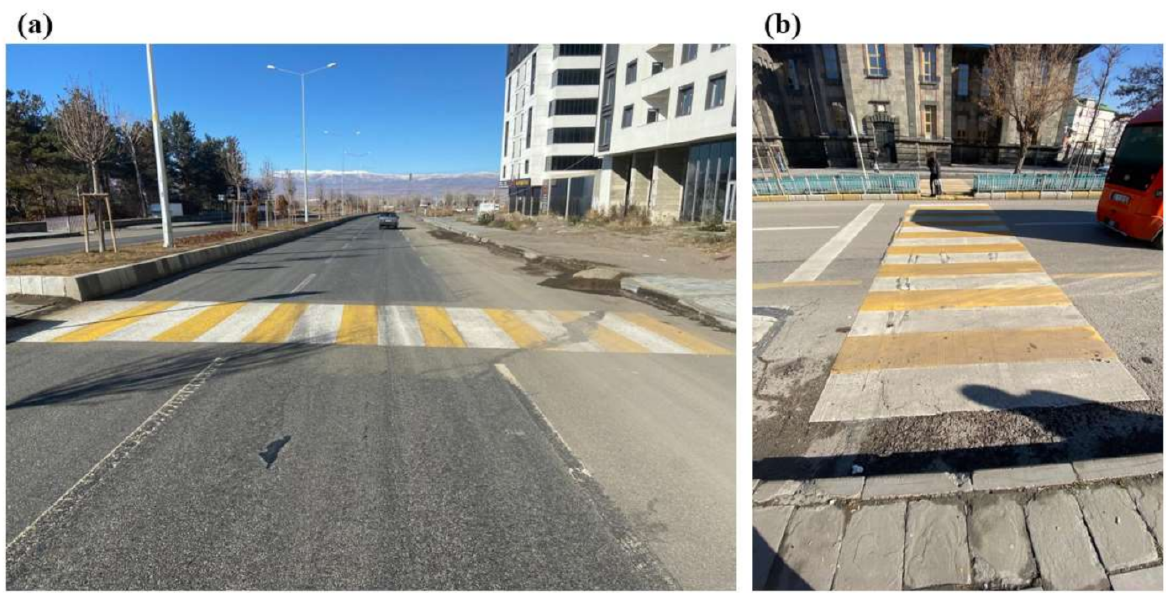
Figure 4. Sample images from the dataset: ( a ) collected data considering vehicle direction, and ( b ) collected data considering the pedestrian